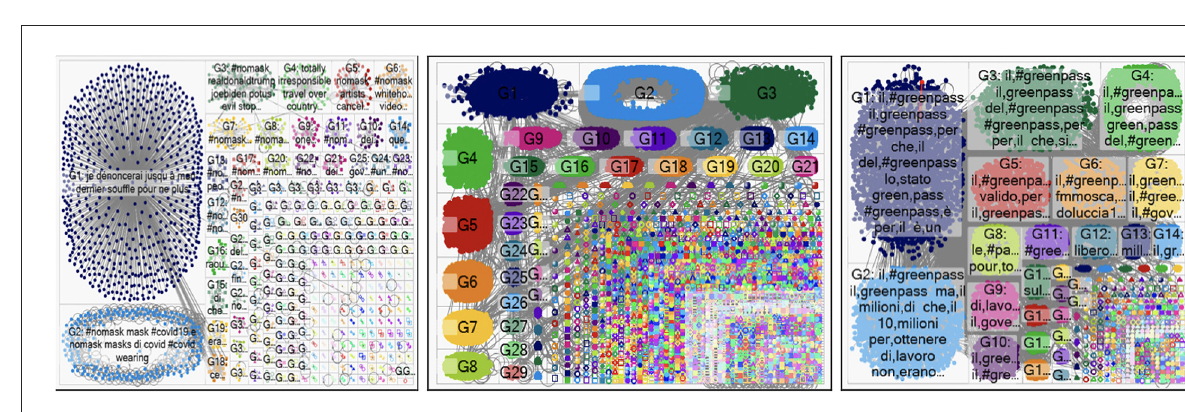
FIGURE4 The representative graphs about “No-mask,” “COVID-19,” and